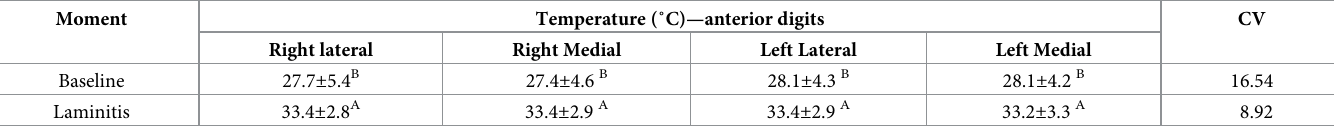
Table 1. Mean, standard deviation and Coefficient of Variation (CV) of the mean temperature (˚C) of the anterior and lateral digits of bovines before and after oli- gofructose-induced laminitis. Moment